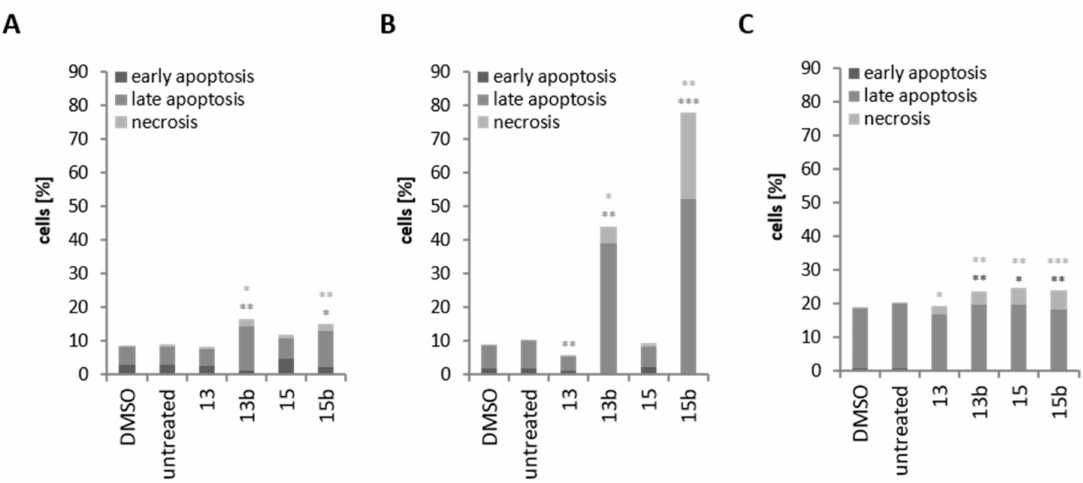
Figure 6. Annexin PI staining. HS578T ( A ), MDA-MB-231 ( B ) and MCF-7 ( C ) cells were treated with 20 µ M 13 , 13b , 15 and 15b for 24 h under hypoxia (0.1% O 2 ). The supernatant and cells were collected and stained with annexin V-PI. Cells stained negative for both annexin V and PI were alive. Early apoptotic cells stained positive for annexin V but negative for PI, whereas late apoptotic or dead cells stained positive for both annexin V and PI. Necrotic cells are indicated as negative for annexin V but positive for PI. Data represent mean values of at least three independent experiments. Significant p values are highlighted with asterisks (* p ≤ 0.05, ** p ≤ 0.01, *** p ≤